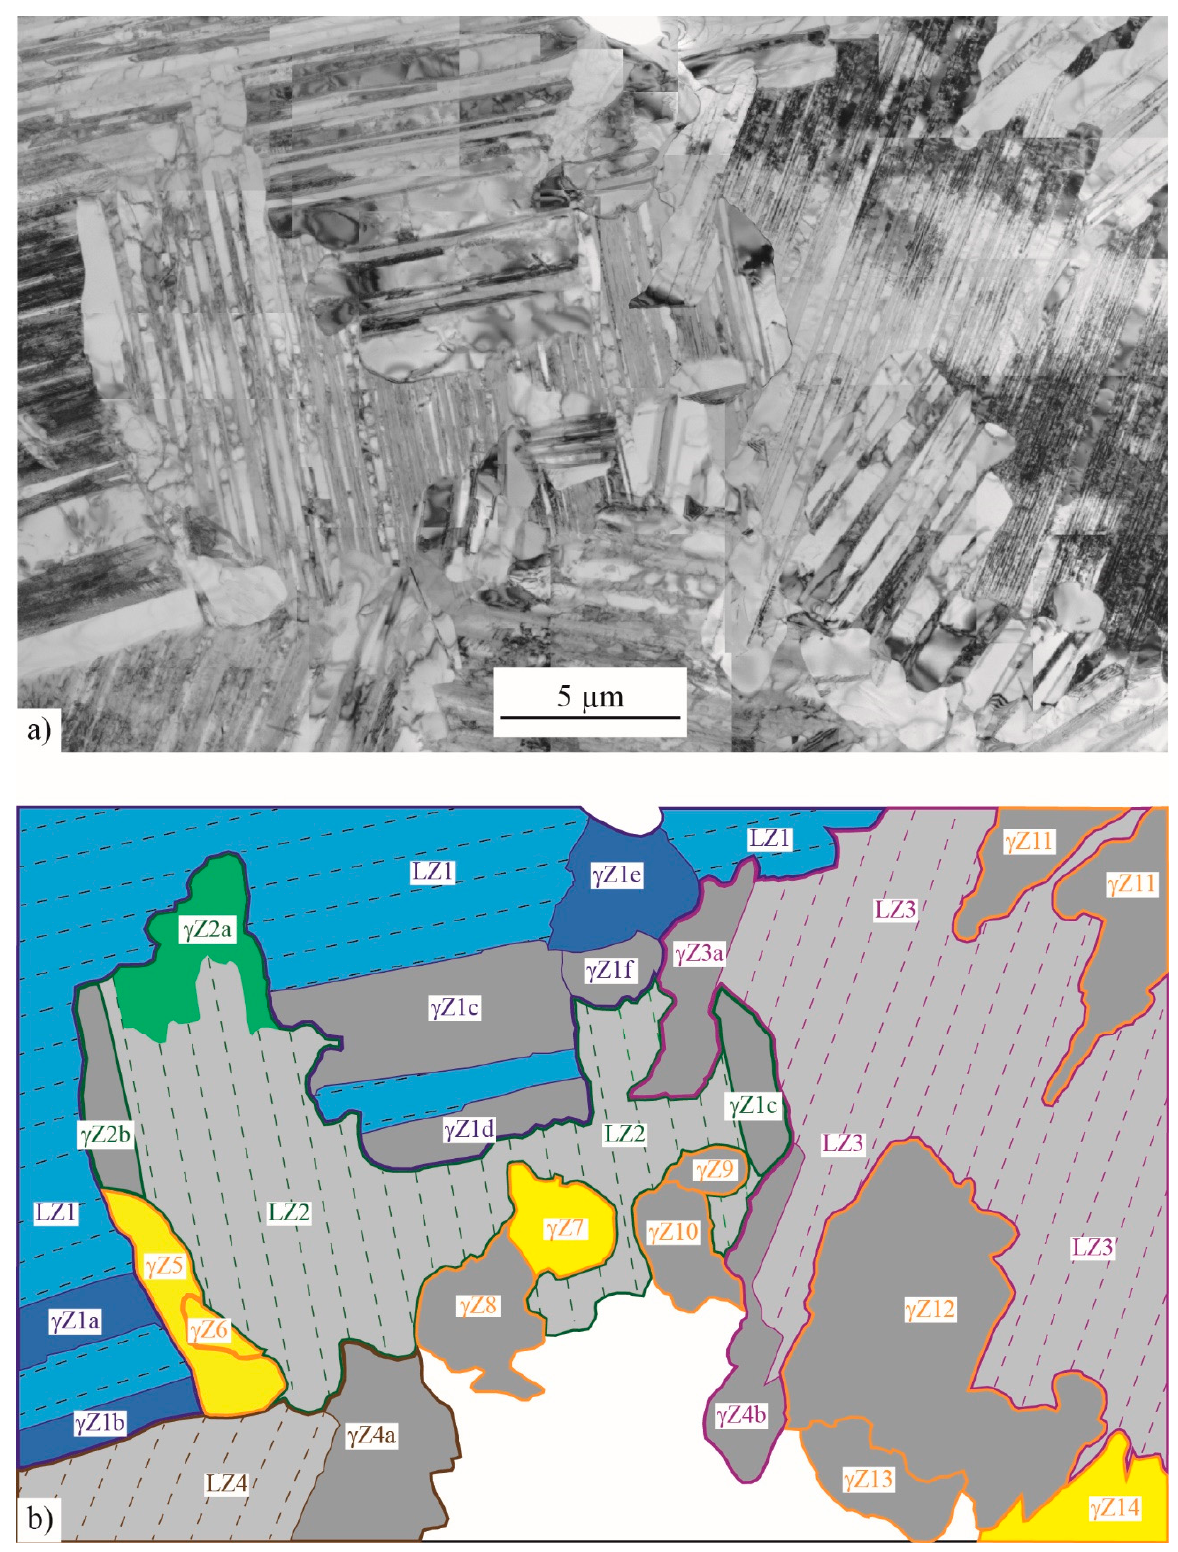
Figure 9. Post-mortem analysis of a 595 µm 2 area of a TNM + specimen by TEM. ( a ) Bright field image of the area; and ( b ) schematic drawing of the same area on which is indicated the type of microstructural feature (LZ for lamellar zones, γ Z for γ grains). See text for the explanation of the colour code. The white area has not been analysed.